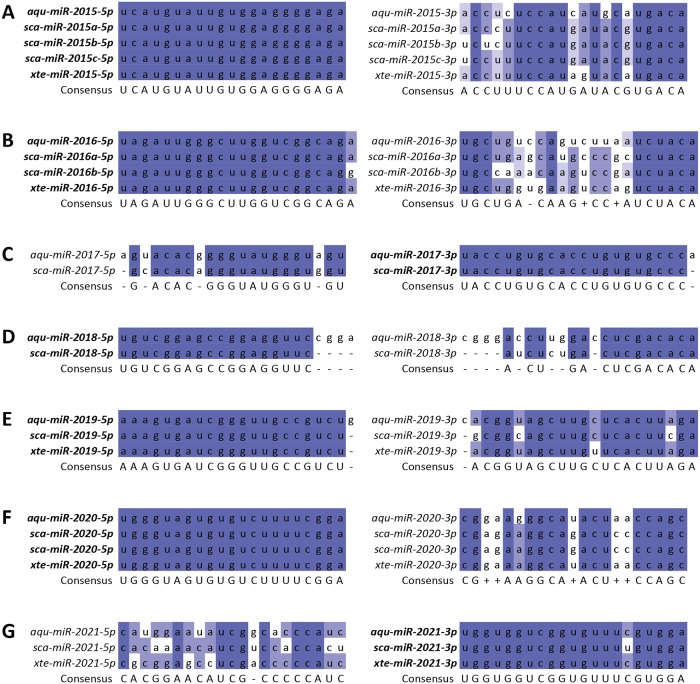
Alignments of predicted S. carteri and X. testudinaria miRNAs against known A. queenslandica miRNAs.Homologues of (A) aqu-miR-2015, (B) aqu-miR-2016, (C) aqu-miR-2017, (D) aqu-miR-2018, (E) aqu-miR-2019, (F) aqu-miR-2020, and (G) aqu-miR-2021 were identified in S. carteri and X. testudinaria. The miRNA sequences from the 5’ and 3’ arms are presented on the left and right, respectively. The bolded name denotes the arm that had more reads mapped to it (i.e., the mature arm for that miRNA). Bases are coloured to enable visualisation of the conservation level, as follows: dark blue, > 80%; blue, > 60%; light blue, > 40%; uncoloured, ≤ 40%). The abbreviations are as described in Fig 1.